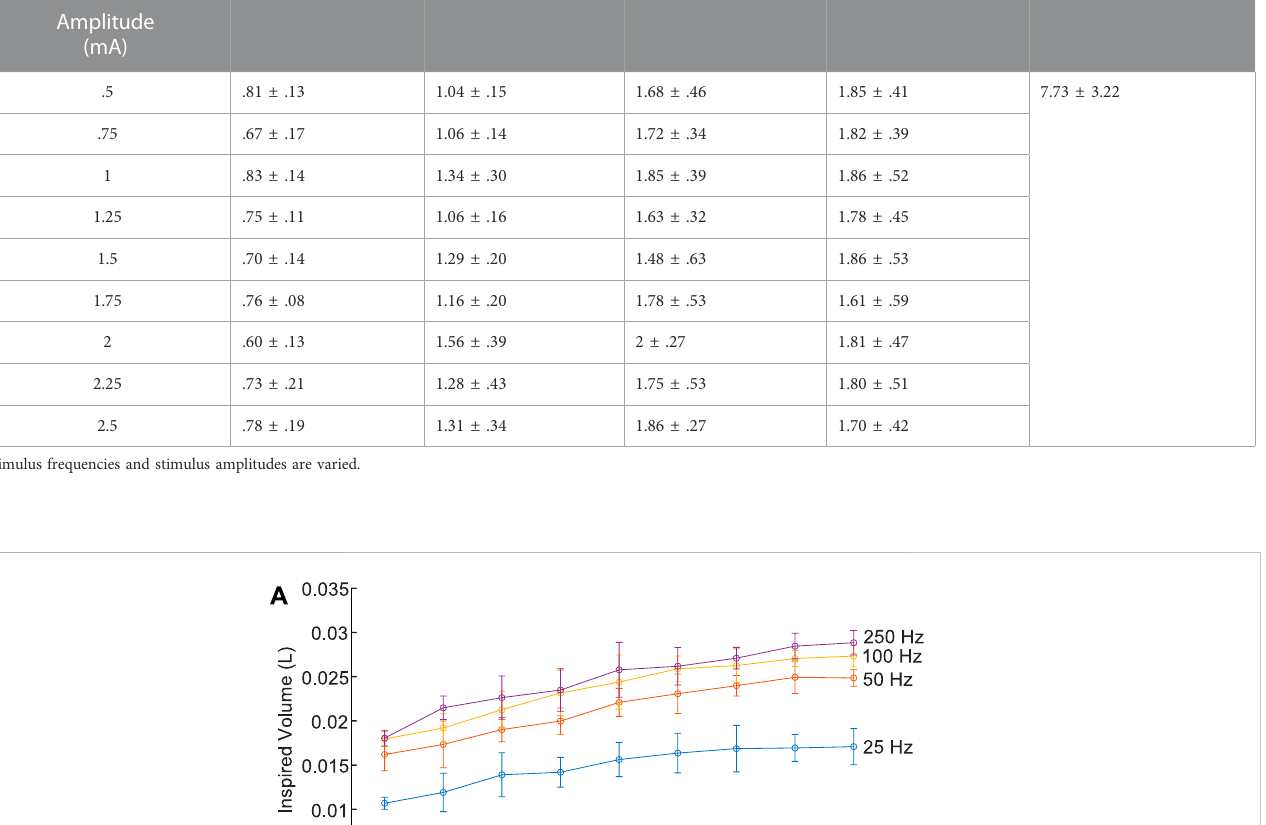
Figure 5 shows changes in Air fl ow Index (b) for inspiratory phase during anesthesia and DP with wide range of stimulus frequencies and amplitudes. b values allow us to assess changes in characteristics of inspiratory air fl ow during DP with various parameters. It was observed that the power equation fi t downward and upward concavity of the